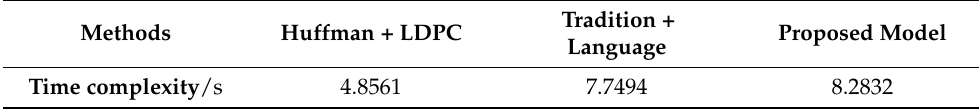
Table 2. The average execution time for each sentence on three